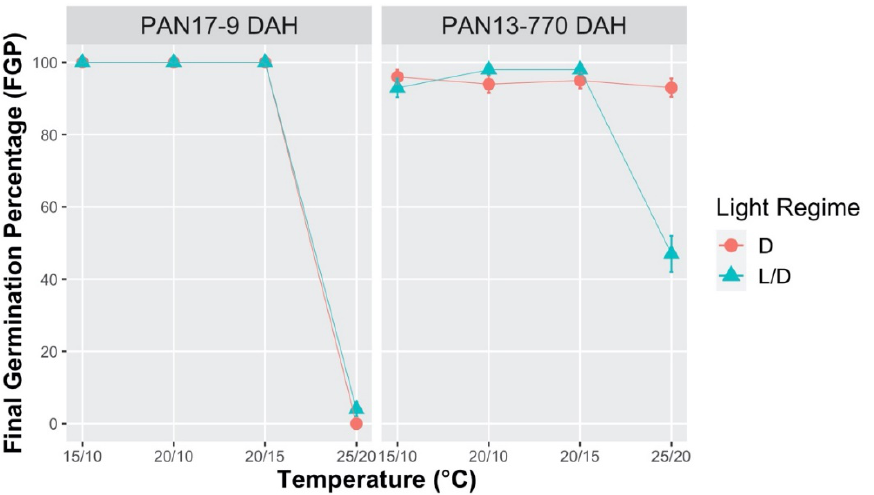
Figure 3. Effect of alternating temperatures (15/10 °C, 20/10 °C, 20/15 °C, and 25/20 °C), on the final germination percentage (FGP) of S. hicesiae , at two different seed ages (9 and 770 days after harvest = DAH), under Light/Dark (L/D 12/12 h) and continuous Dark (D 24 h) conditions. Seeds were collected across two years (2013 and 2017) from the PAN seed source.